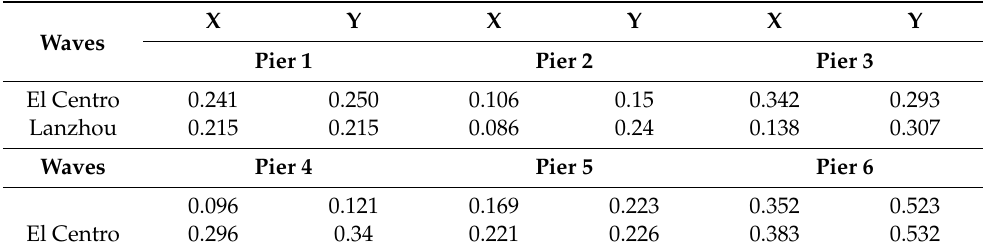
Table 4. Peak acceleration at the top of the piers ( g